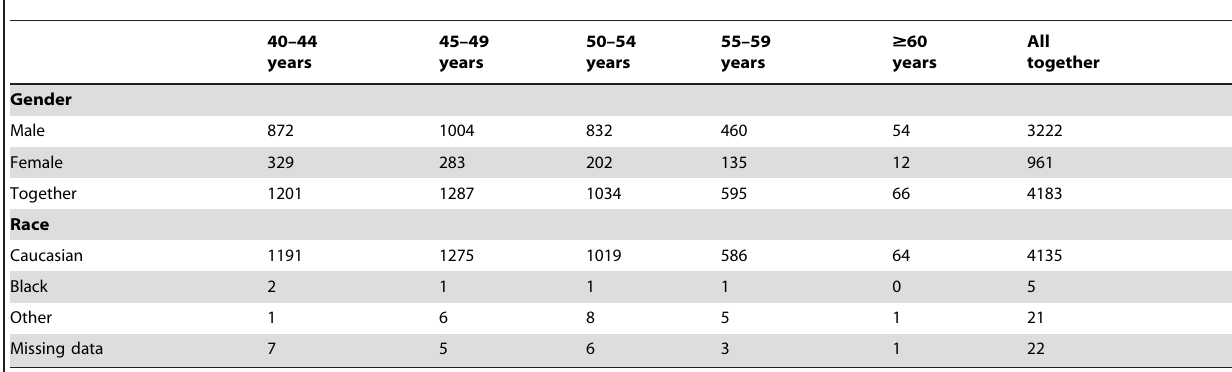
Table 5. Distribution of gender and race for all participants